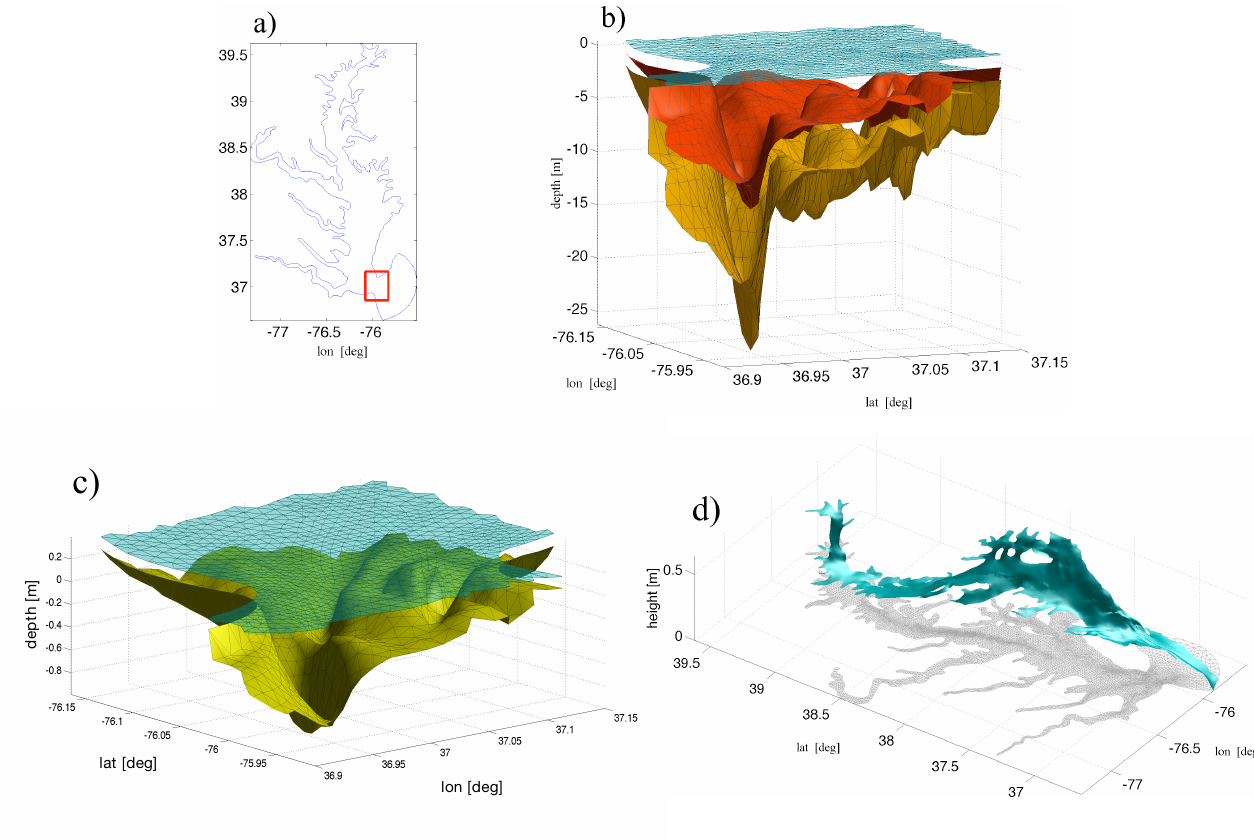
Fig. 2. Instantaneous geometry of the computational sigma levels, 6 σ , σ i ∈ Z ∗ , (see (10)) used by Quoddy to model the flow in the Chesa- i peake Bay; horizontal to vertical aspect ratios are not preserved and only a small region is shown, as indicated by the red rectangle in (a) . The 3-D mesh has 15 sigma levels, each containing 9700 triangular elements. (b) Instantaneous geometry of 6 1 (free surface, cyan), 6 8 (red), and 6 15 (brown; the bottom). (c) Instantaneous geometry of 6 1 and 6 2 ; these would be almost indistinguishable on the scale of (b). (d) Instantaneous geometry of the free surface in the whole